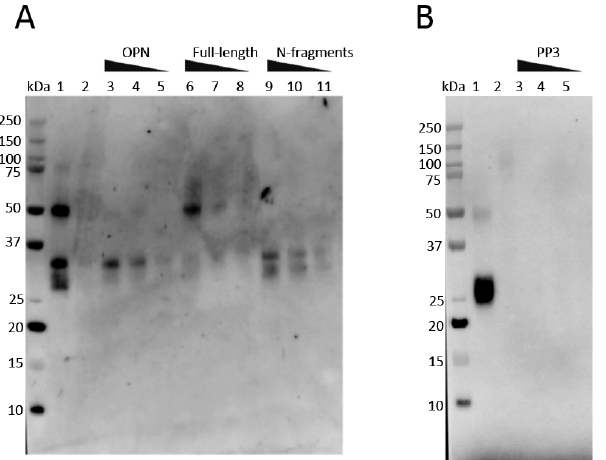
Figure 2. Western blotting of Caco-2 cell lysates after incubation with osteopontin (OPN), full-length OPN, or N-terminal OPN fragments separated by gel filtration. Cell lysates were incubated with anti-OPN IgG-coupled Dynabeads before Western blotting, and OPN was detected using the biotinylated anti-OPN antibody MAB193p. ( A ) Lane 1, 100 ng OPN (positive control for purification); lane 2, cells incubated without OPN; lanes 3–5, cells incubated with OPN (lane 3, 100 µ g/mL; lane 4, 50 µ g/mL; lane 5, 10 µ g/mL); lanes 6–8, cells incubated with full-length OPN (lane 6, 100 µ g/mL; lane 7, 50 µ g/mL; lane 8, 10 µ g/mL); lanes 9–11, cells incubated with N-terminal OPN fragments (lane 9, 100 µ g/mL; lane 10, 50 µ g/mL; lane 11, 10 µ g/mL). ( B ) Cell lysates incubated with PP3. PP3 was purified from lysates with anti-PP3 IgG-coupled Dynabeads before Western blotting. Lane 1, 100 ng PP3; lane 2; cells incubated without PP3; lanes 3–5, cells incubated with PP3 (lane 3, 100 µ g/mL; lane 4, 50 µ g/mL; lane 5, 10 µ g/mL). Both blots are representative of three individual experiments.